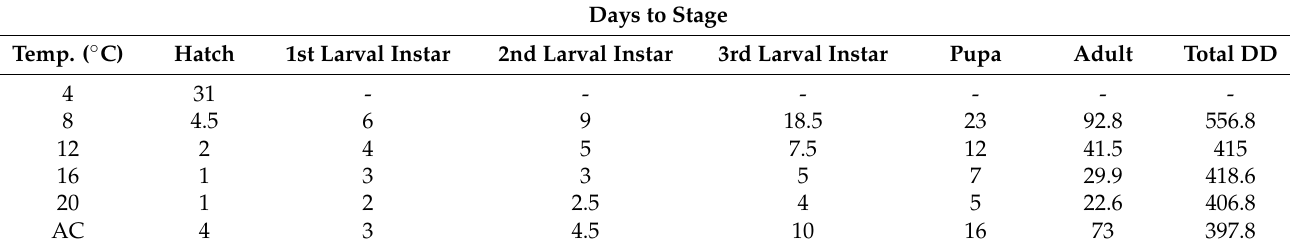
Table 1. Total number of days to reach each developmental stage of Calliphora vicina ‘s life cycle from hatching a , and number of degree days (DD) to reach adulthood b , in the Kerguelen Islands strain reared under different thermal conditions (4, 8, 12, 16, and 20 ◦ C and ambient temperatures (ambient conditions, AC)) at Port-Aux-Français, Kerguelen Islands. Ambient temperatures were measured